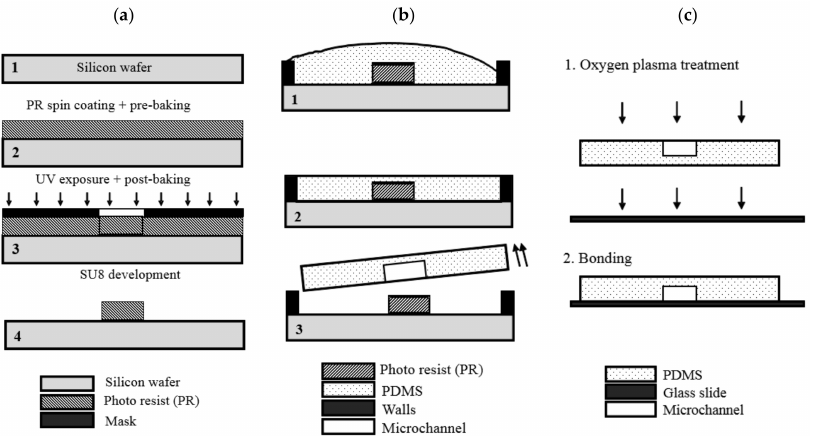
Figure 2. Schematic view of microfluidic system fabrication process using soft lithography; ( a ) mold fabrication step using soft lithography; ( b ) microchannel fabrication step using polymeric material; ( c ) bonding step using oxygen plasma